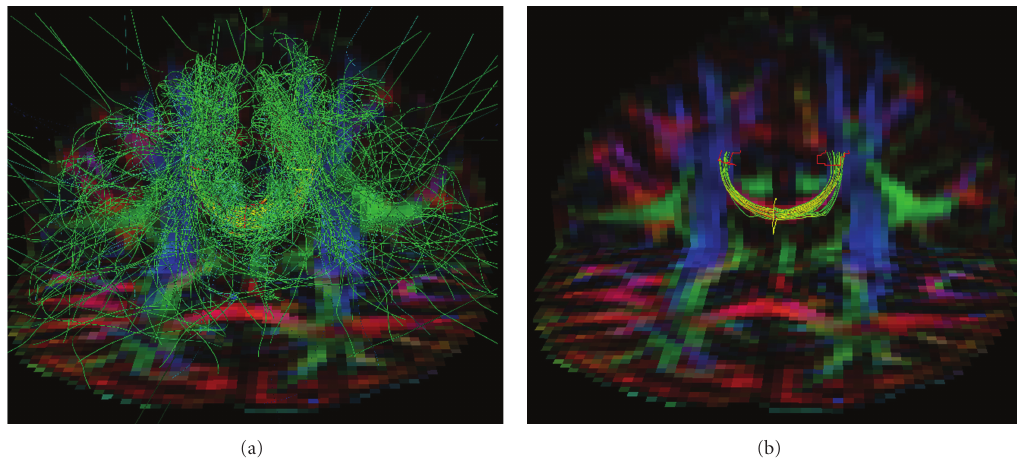
Figure 8: Fibers computed using the CUDA ray-tracing algorithm in real data. (a) All fibers computed from a seeding region in part of the corpus callosum. (b) In order to properly analyze the computed fibers, a postprocessing step is needed. In this case, fibers were filtered through two target regions of interest and ranked and colored according to their Connectivity Measure value (see Section 2.3). The yellow polygon approximates the seeding region used for the benchmarks in Section 5.3. Both images were generated in the DTITool